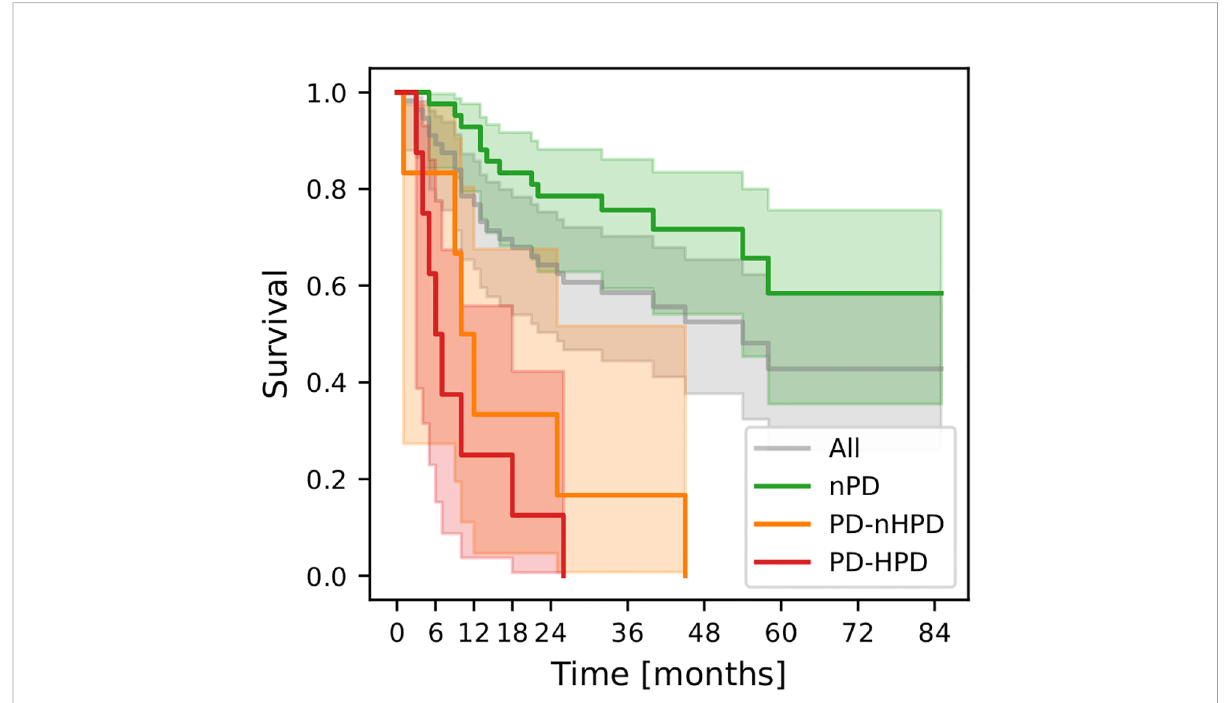
FIGURE 3 Kaplan-Meier curves for the whole cohort (All; n=56), non-progressing patients (nPD; n=42), progressing but not hyperprogressing patients (PD-nHPD; n=6), and hyperprogressing patients (PD-HPD; n=8). Survival functions were estimated with respect to the landmark (3 months) and not to the start of